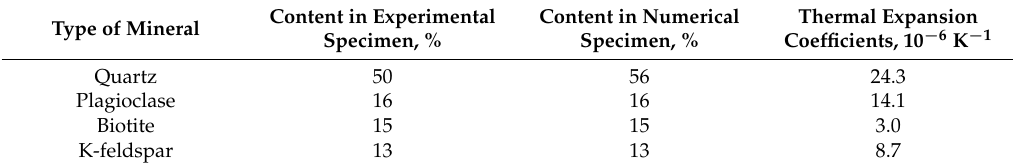
Table 1. Contents and thermal expansion coefficients of minerals in the Strathbogie granite specimen [5].